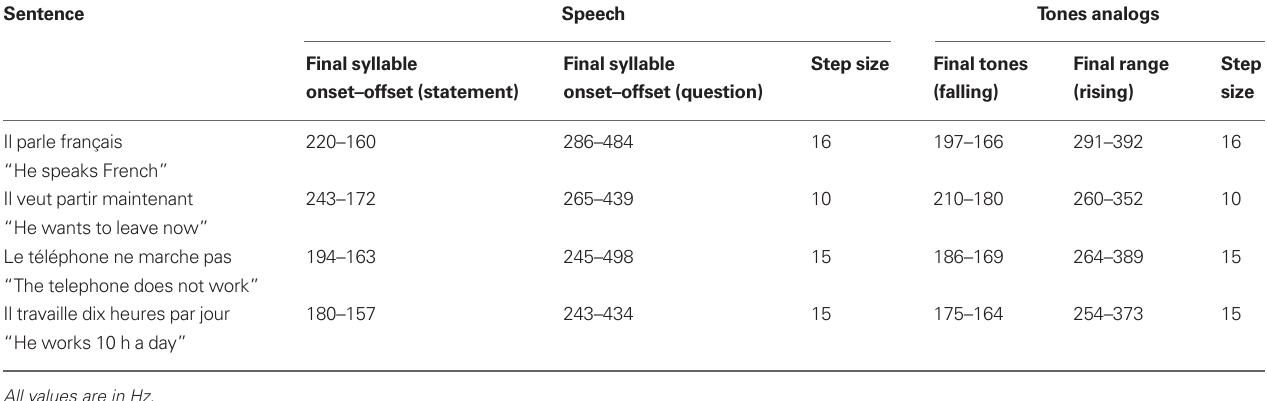
Table 2 | The F 0s of the onset and offset of the final syllable for speech, and of the final two tones for tone analogs are displayed for the outermost steps of each sentence, labeled “Statement” and “Question” here for speech, and “Falling” and “rising” for tone analogs. The average step size (the frequency difference between successive steps) is also shown for each stimulus.